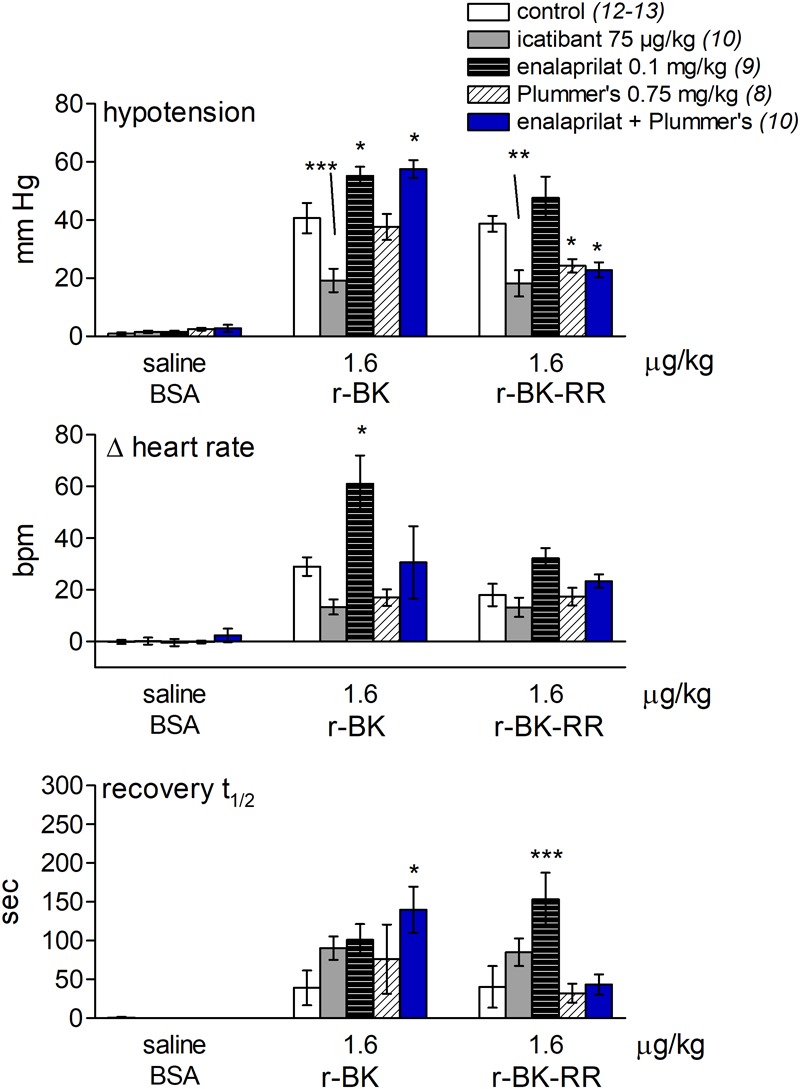
Bar graph showing the effects of icatibant and peptidases inhibitors on the cardiovascular responses to i.v. bolus injections of saline-BSA vehicle, r-BK or r-BK-RR in anesthetized rats. The (upper) panel represent the effect of i.v. pretreatment with icatibant (0.75 mg/kg), enalaprilat (0.1 mg/kg), Plummer’s inhibitor (0.75 mg/kg) or enalaprilat (0.1 mg/kg) + Plummer’s inhibitor (0.75 mg/kg) on the maximal hypotensive response to i.v. bolus injections of 1.6 μg/kg of r-BK and r-BK-RR in anesthetized rats. The pretreatment with each inhibitor was given 15 min before starting with the control injection of vehicle. The (middle) panel represent the maximal tachycardic response during hypotensive episodes induced by the indicated peptides and reported in the (upper) panel. The (bottom) panel represent the recovery half-time for hypotensive episodes induced by the indicated peptides and reported in the (upper) panel. In all panels, values are means ± SEM shown by vertical lines and the number of determinations in the different group of rats is given between parentheses for controls and each inhibitor. ANOVA indicated that specific sets of values differed significantly between them (p < 0.05): the effects of r-BK on all three readouts and those of r-BK-RR on blood pressure and recovery time. Dunnett’s test was applied within these sets of drug pretreatments vs. controls values. ∗p < 0.05, ∗∗p < 0.01, ∗∗∗p < 0.001.